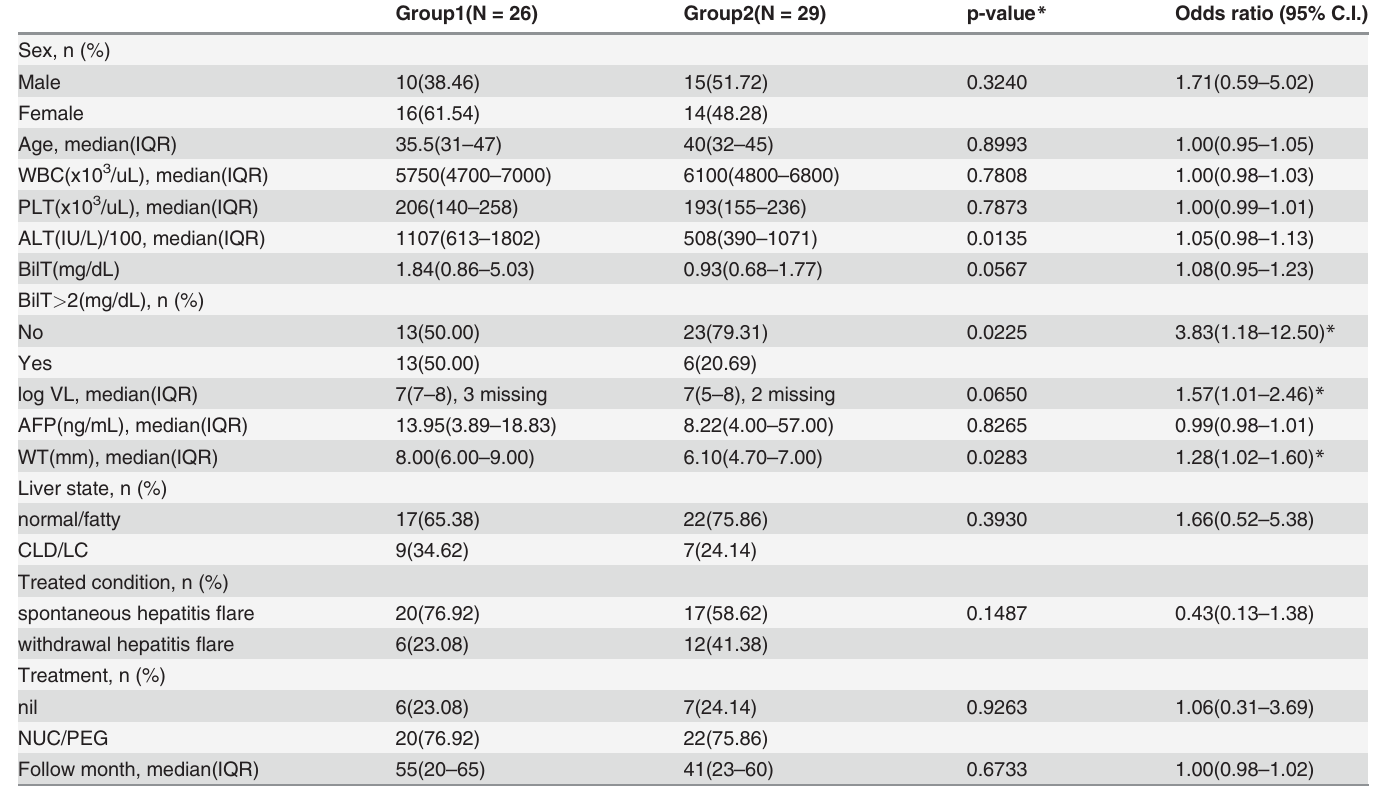
Table 4. The distributions of baseline characteristics and variable factors during acute fl are including the results of nodal width for group 1 and